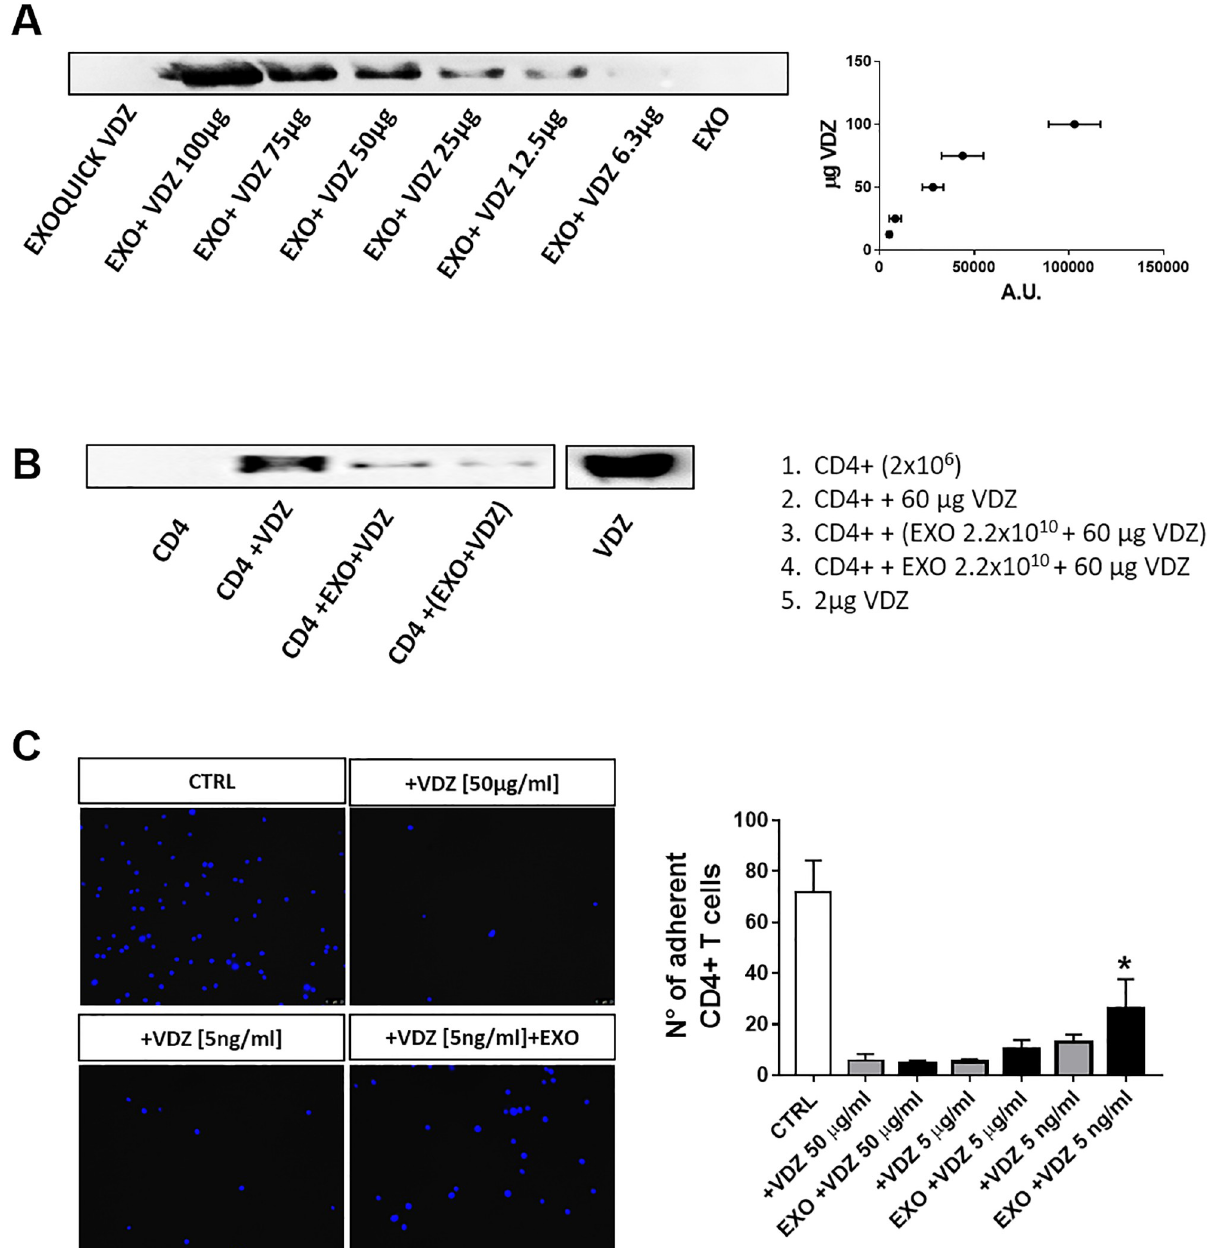
Fig 5. Exosomes compete with T cells for binding to VDZ. VDZ bound to exosomes (A) or to CD4+ T cells (B) were evaluated by native immunoblotting. One representative blot is shown of three independent experiments. (C) CD4+ T cells were incubated with VDZ with or without exosomes and added to MAdCAM-1-coated plate. Representative microscope images of adherent cells stained with Hoechst dye are shown. Data are shown as mean ± SD. � p < 0.05 compared to adherent cells treated with 5 ng/ml VDZ alone. bound to cells were then measured by native immunoblotting. We found that the amount of VDZ bound to cells was impaired in the presence of exosomes, either if exosomes were pre- incubated with VDZ or given with VDZ simultaneously to CD4+ T cells (Fig 5B). We next evaluated the capacity of exosomes to interfere with the adhesion of VDZ-treated CD4+ T cells